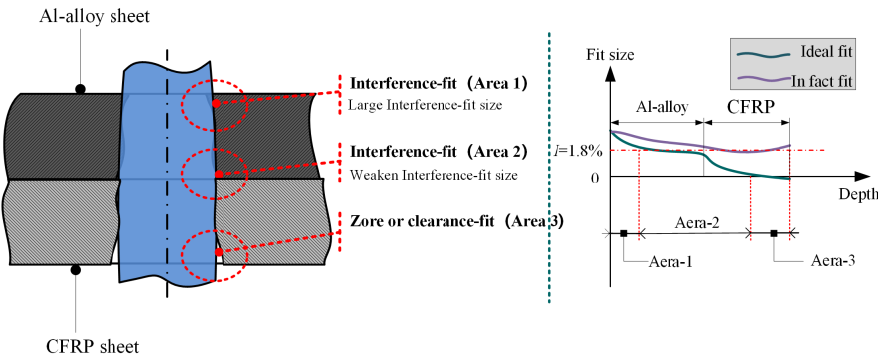
Figure 2. Two interference-fit curves of composite/Al alloy sheets.